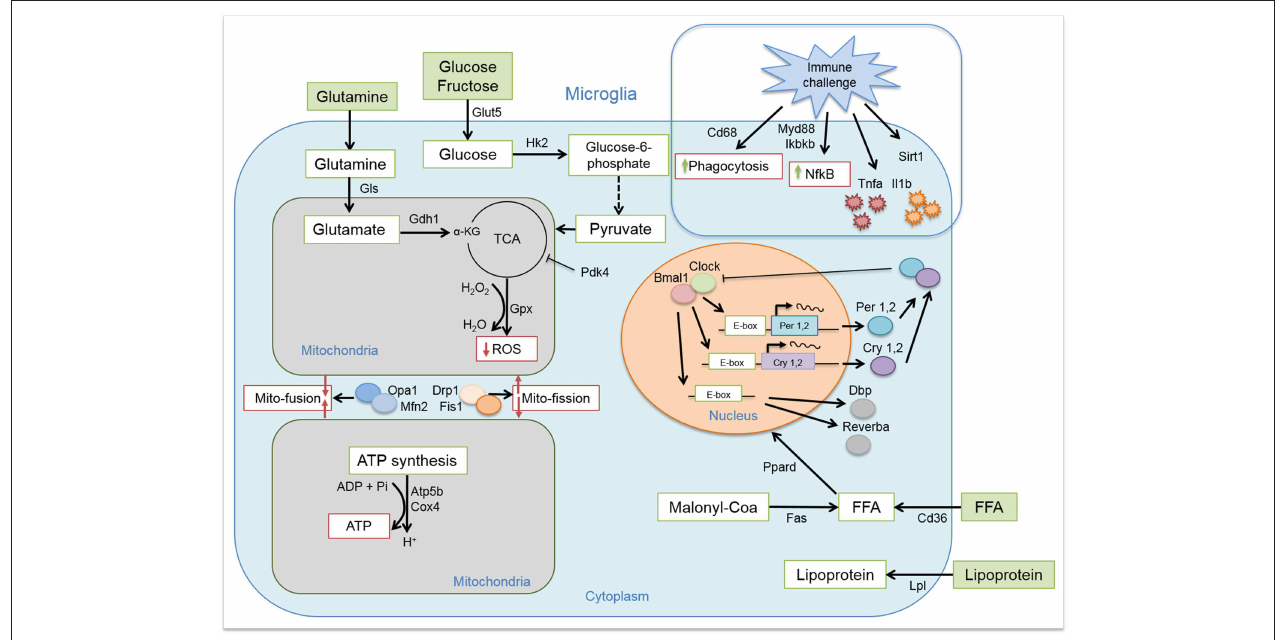
FIGURE 1 | Microglial circadian, immune, metabolic, and mitochondrial profile. Schematic representation of the pathways and/or functions tested on microglial cells from chow- and HFD-fed rats.